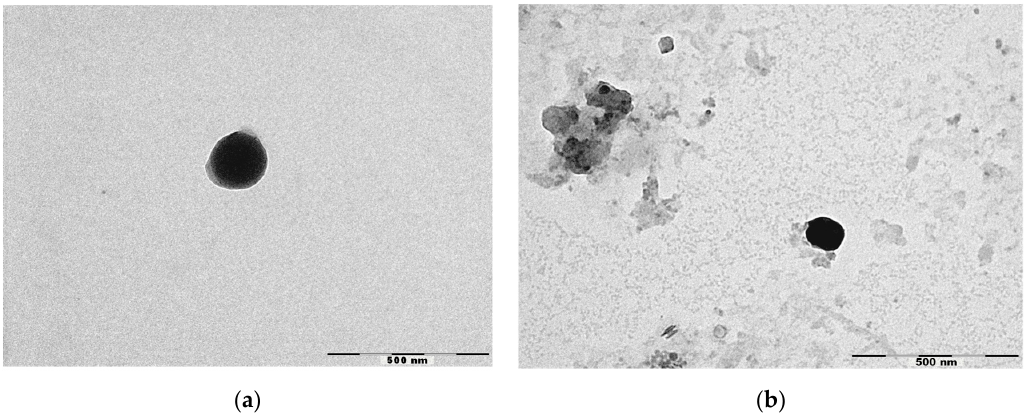
Figure 1. Micrographs obtained by TEM of ( a ) NLC 4 and ( b ) NLC-RSV 4 . Scale bar = 500 nm.